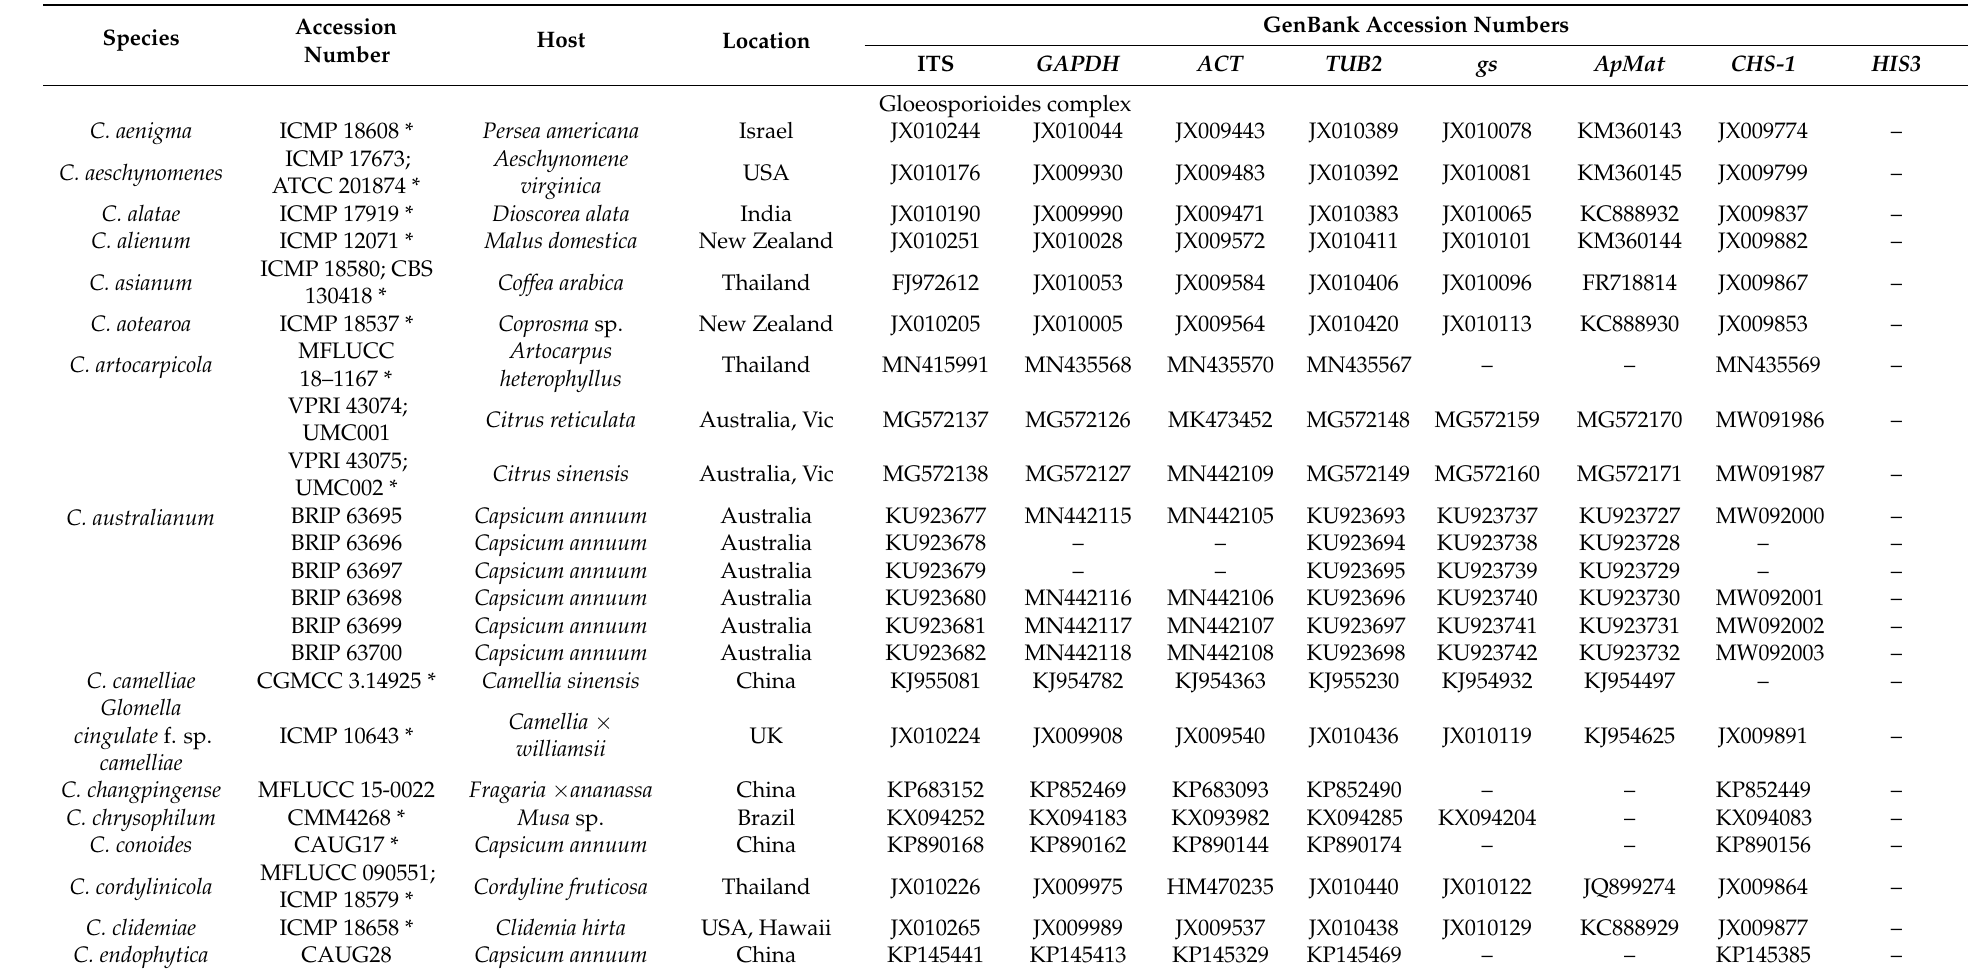
Table 2. Strains of Colletotrichum species used in the phylogenetic analyses with details of host and location, and GenBank accession numbers of the sequences.